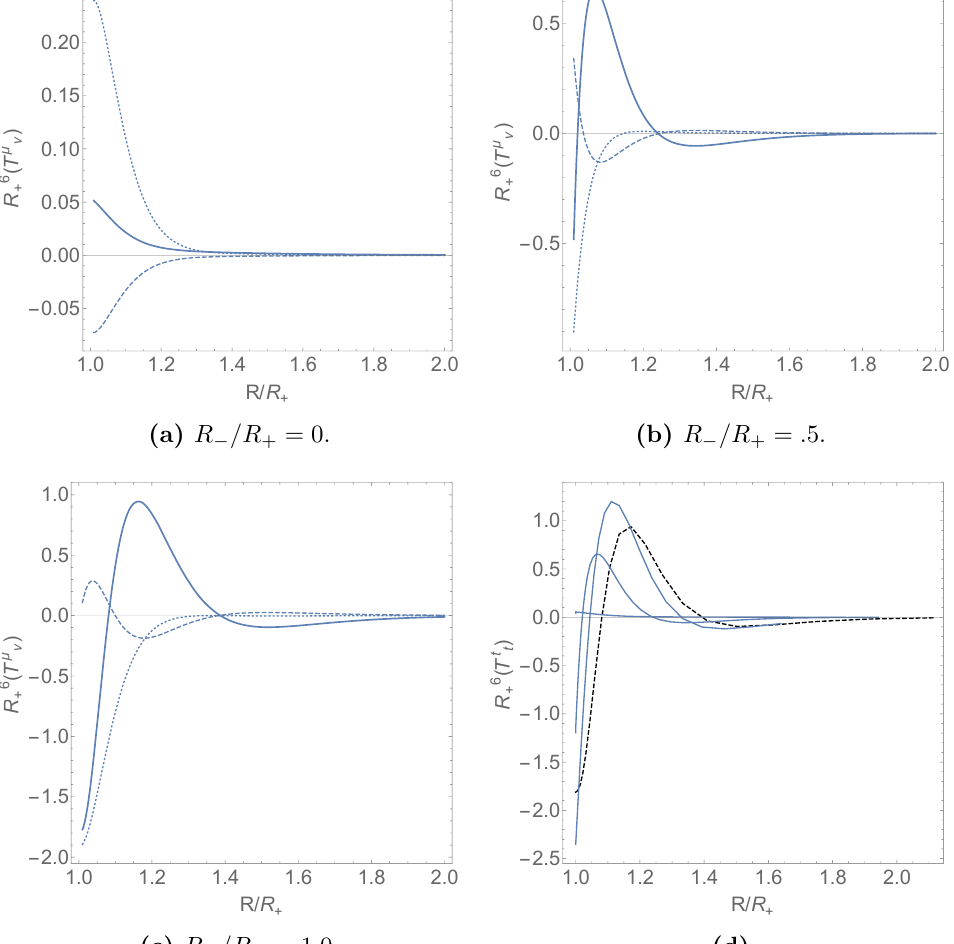
h T (cid:22) i as a function of R for di(cid:11)erent values (cid:23) 3 l 5 , the dotted line is T r t